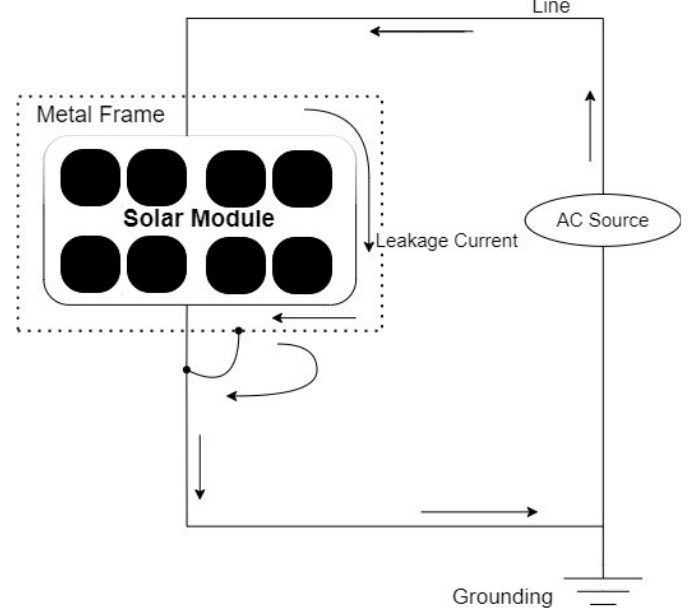
Figure 6. Conventional grounding of PV system with metal frame.